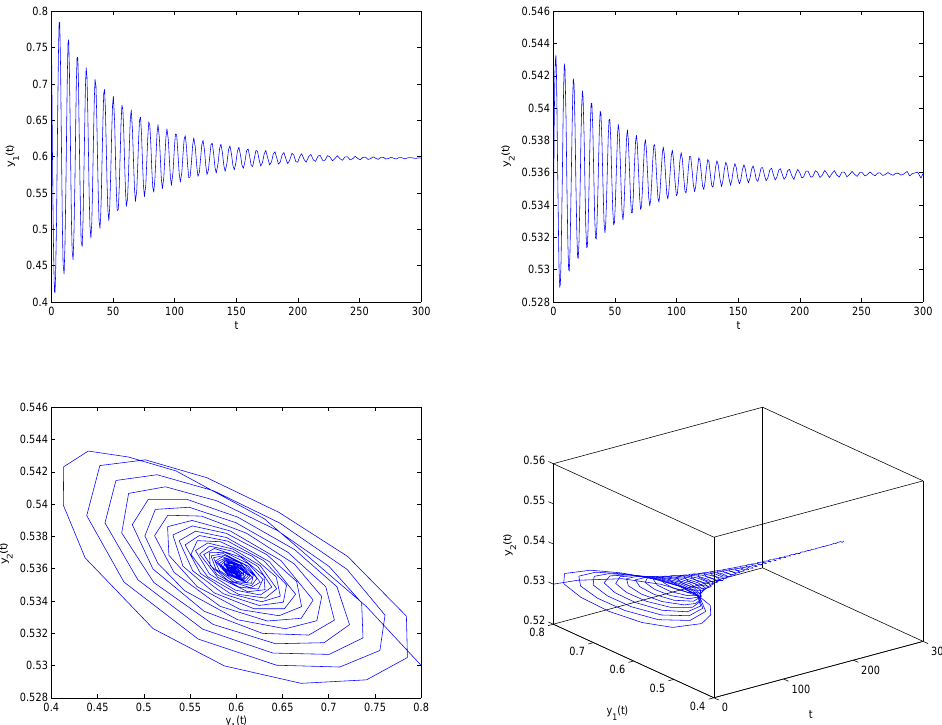
Figure 1. Numerical simulation results of model (62) concerning θ = 1.52 < θ 0 = 1.7. The positive equilibrium point Y ( 1.0221,16.0947 ) remains at a locally asymptotically stable level.